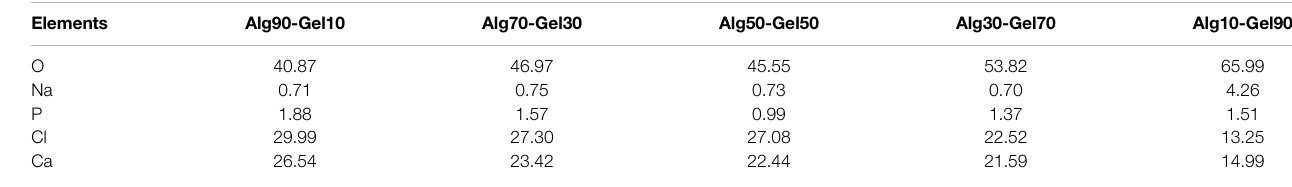
TABLE 3 | Distribution of elements in composition of different ratios (%) Elements Alg90-Gel10